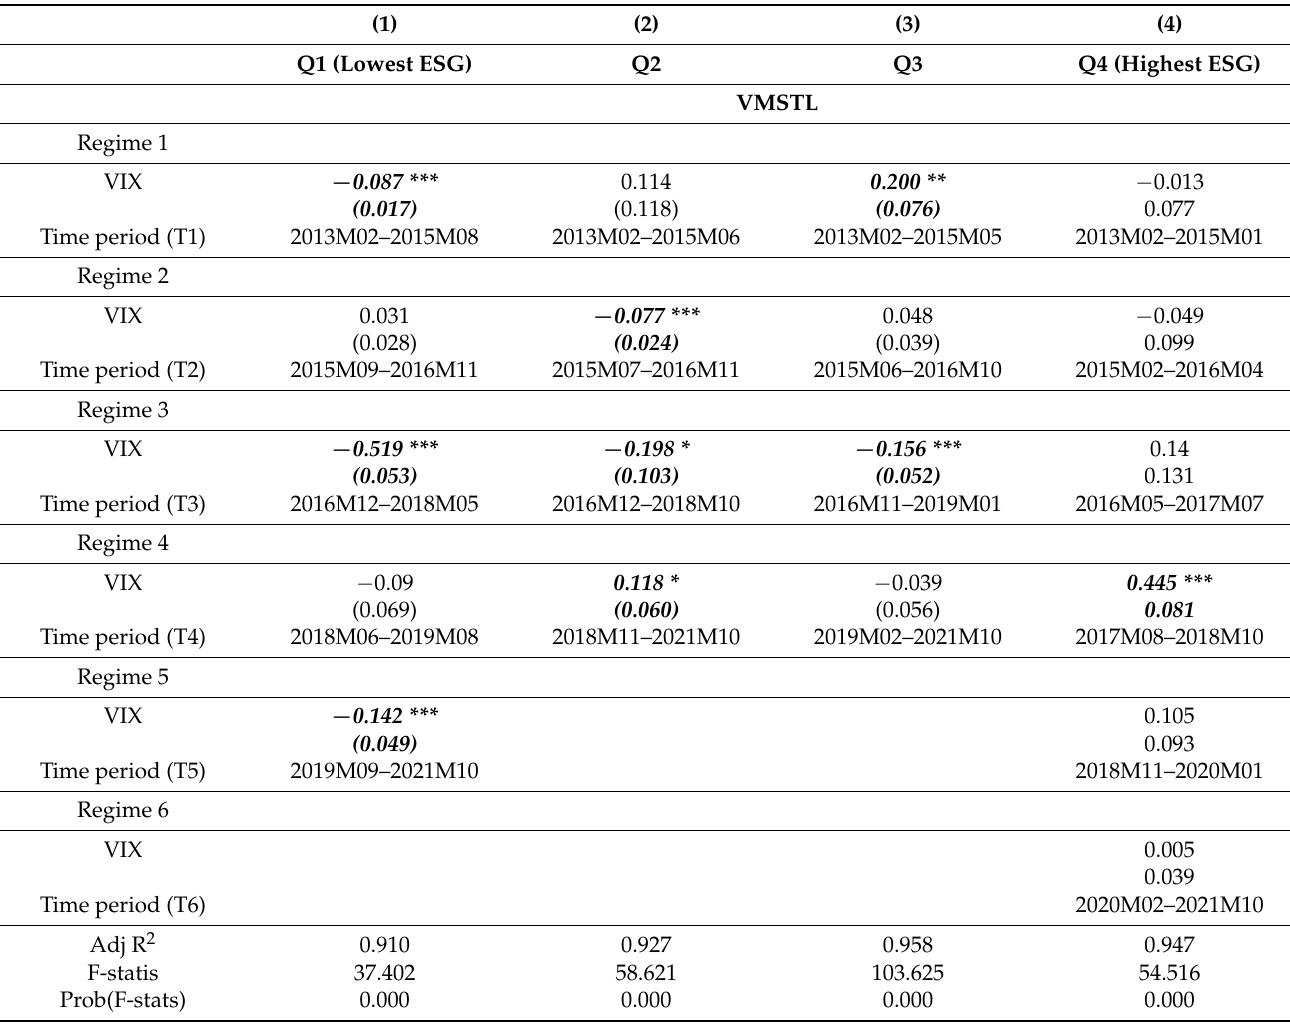
Table 4. Time dependence of